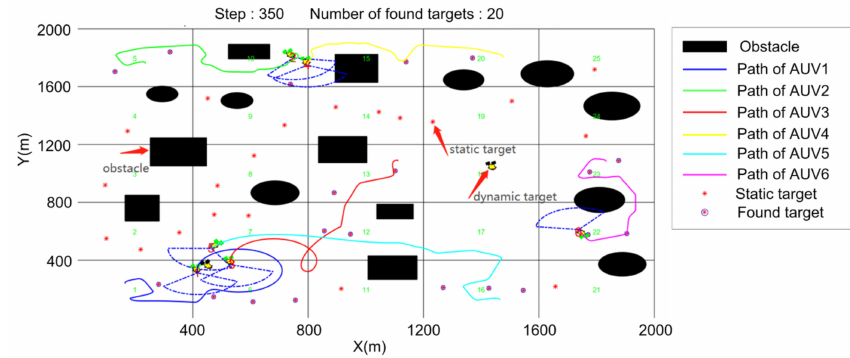
Figure 21. T = 345 (steps).